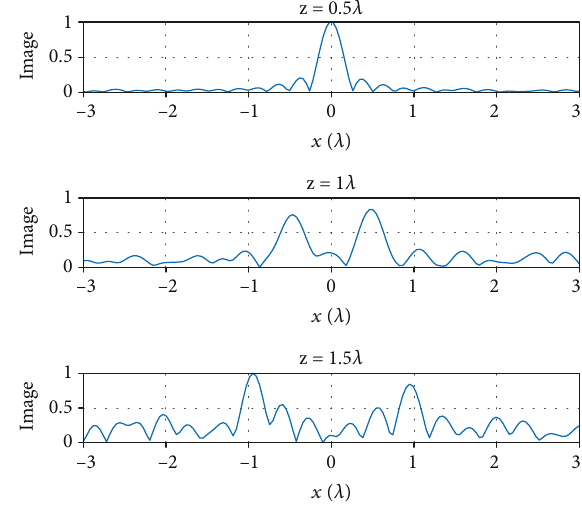
Figure 12: Reconstructed images when using 13 resonant dipole antennas. For this example, the parameters are z z =0.3 λ , d = λ , d =2 λ , s = λ /8, and D =0.25 λ . These results are 3 2 3 with SNR=20